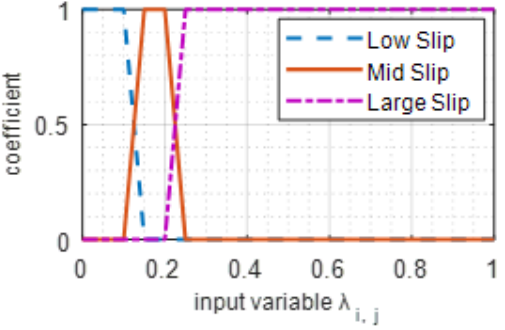
Figure 2. Fuzzy logic vehicle speed estimator input variables based on wheel speed.